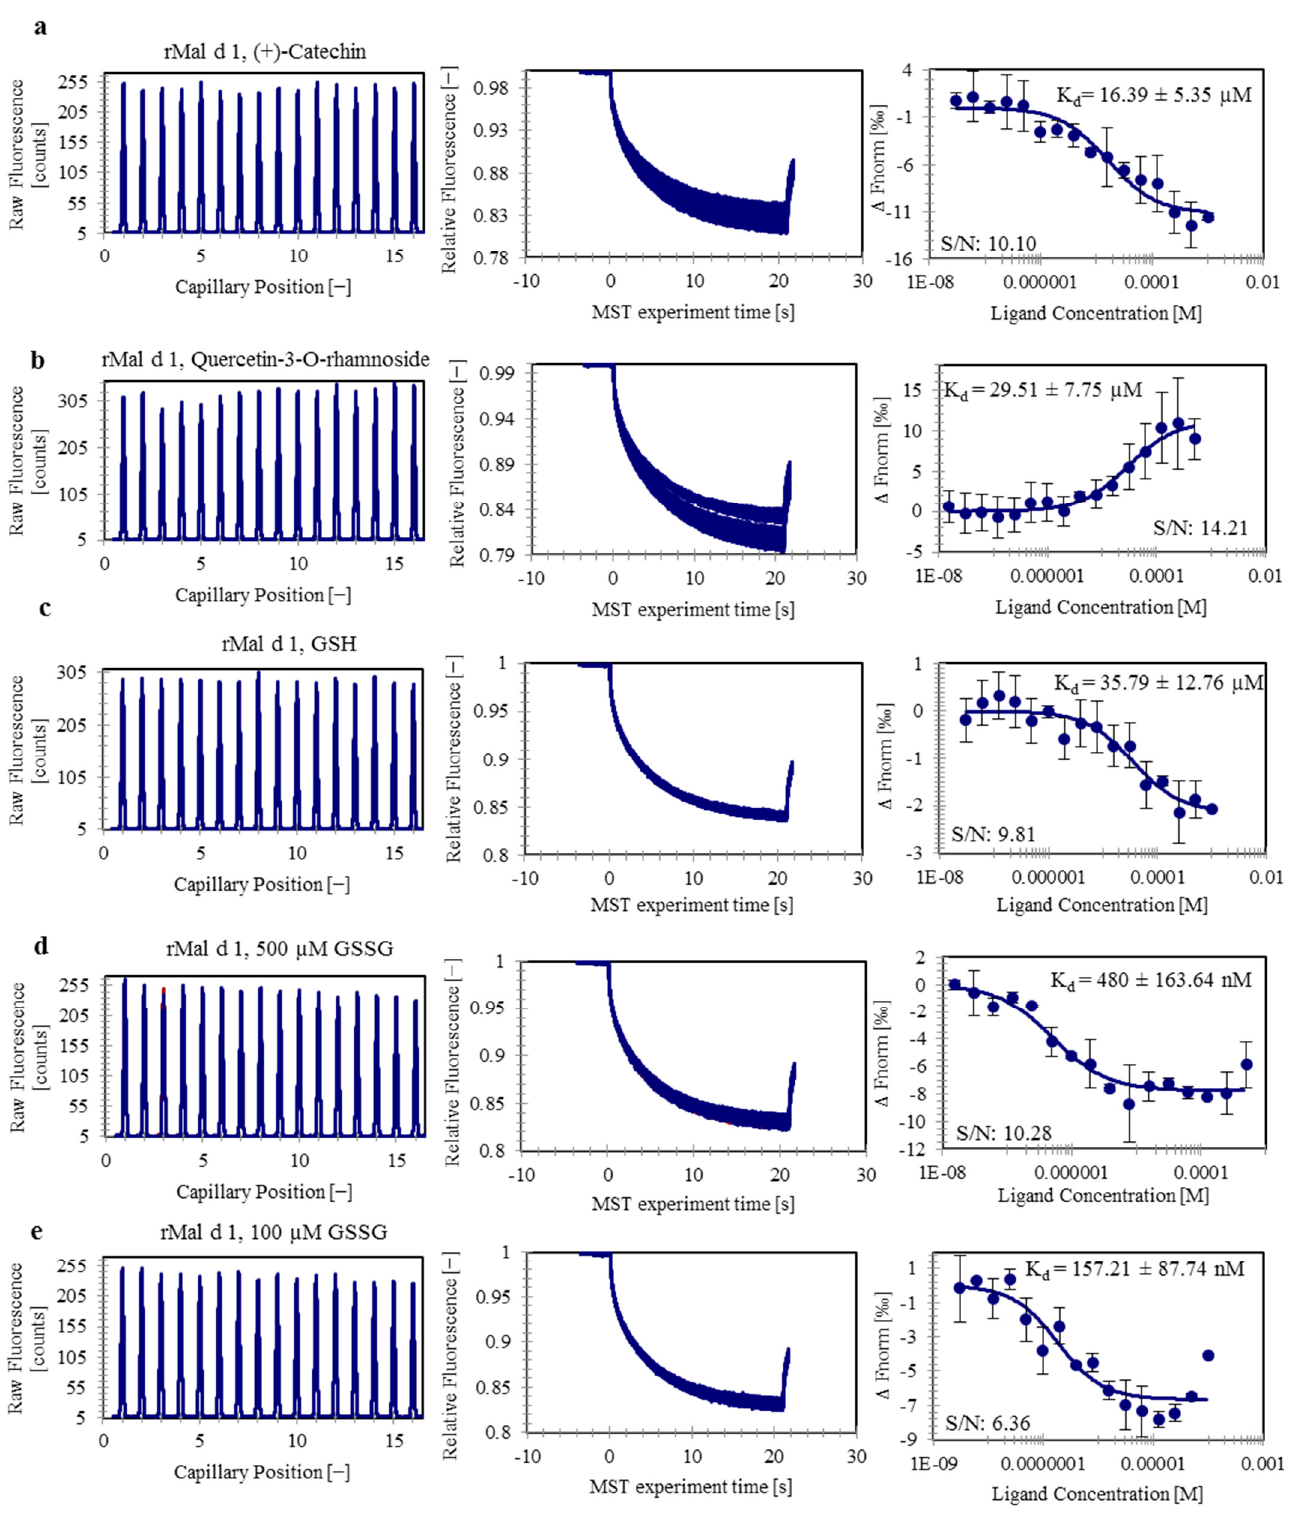
Figure 1. Capillary scan (left), MST traces (middle), and dose–response curves (right) of labeled rMal d 1 bound with catechin ( a ), quercetin-3- O -rhamnoside ( b ), GSH ( c ), GSSG (I) ( d ), and GSSG (II) ( e ). Error bars indicate the standard deviation between the performed technical replicates. Dissociation constants (K d ) and signal-to-noise ratios (S/N) are shown.